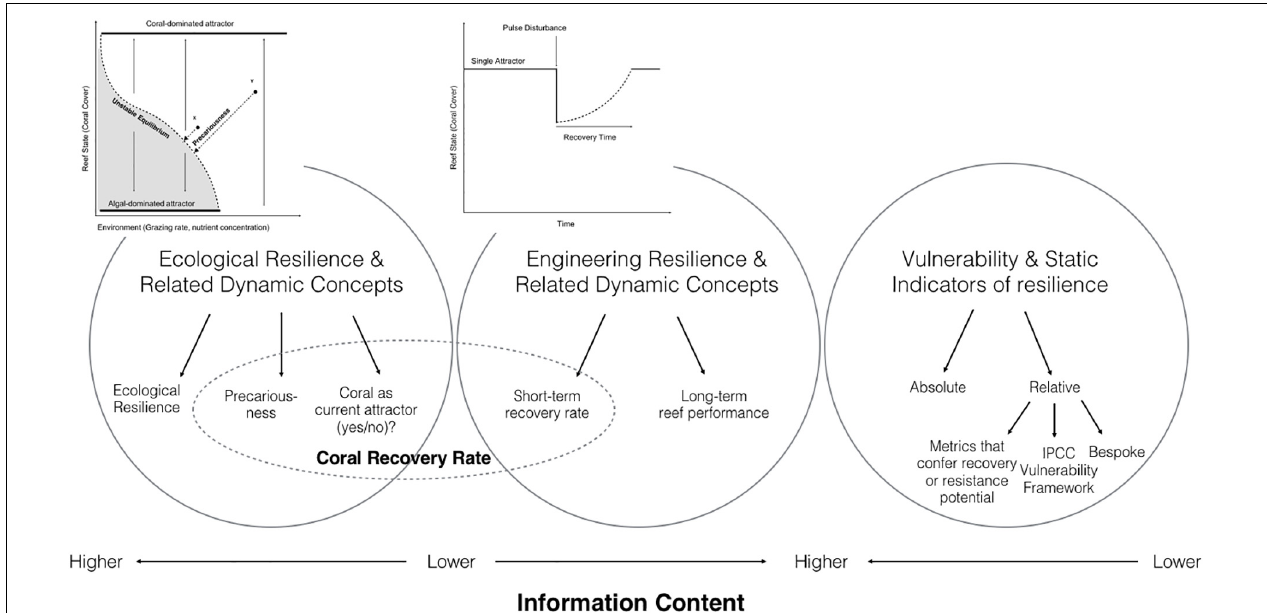
FIGURE 1 | Conceptual diagram of the various methods of measuring ecological resilience, engineering resilience and vulnerability. Precariousness is the distance of a reef to the suspected unstable equilibrium/tipping point. The precariousness of Reef X is greater than Reef Y. Reefs that fall in the shaded gray area has an algal-dominated current attractor, and reefs are in the white area has a coral-dominated current attractor. Dotted line represents cross-cutting methods that relate to coral recovery rate.